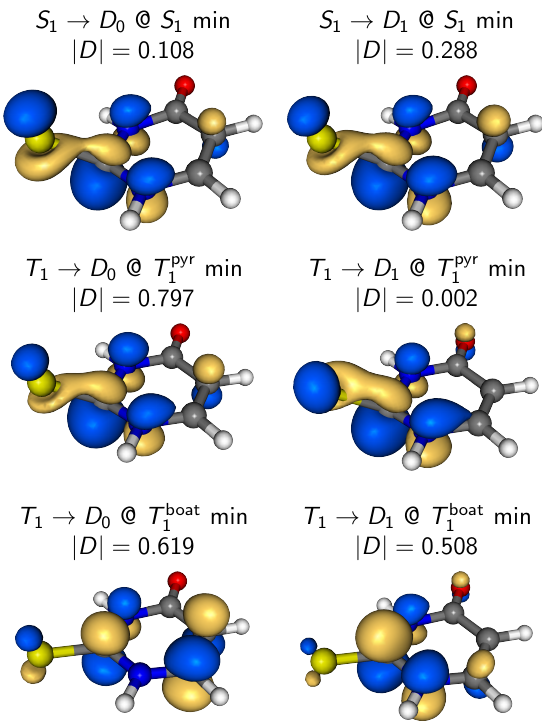
Figure 8. Dyson orbitals computed at the S 1 and T 1 minima of 2TU for ionization from S 1 or T 1 to D 0 or D 1 . Note that, in order to show the renormalized Dyson orbitals, for each plot, we chose the isosurface value as 0.07